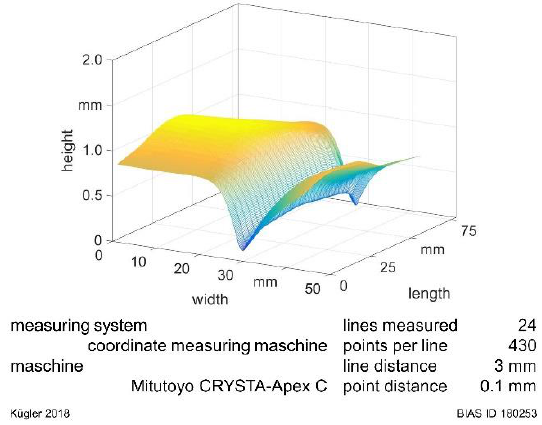
Figure 6. Example of a distortion measurement result with the lowest value set to a height of z = 0.